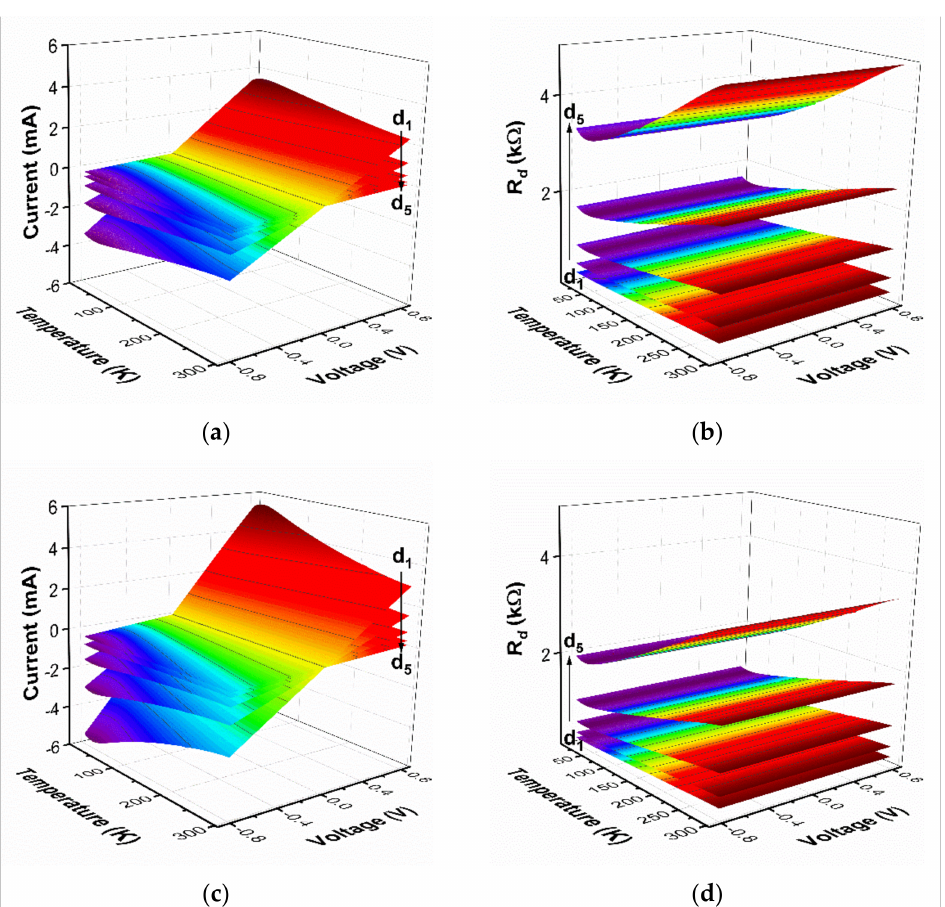
Figure 3. Temperature dependence of I–V and R d –V characteristics in the temperature range of 10–300 K and applied voltage of ± 0.8 V for both types of metallization: ( a , b ) Au electroplating and ( c , d ) Ti-Au vacuum deposition. Curves present data collected from six rectangular contacts separated by distinct distances, where d 1 = 160 µ m, d 2 = 320 µ m, d 3 = 640 µ m, d 4 = 1280 µ m and d 5 = 2560 µ